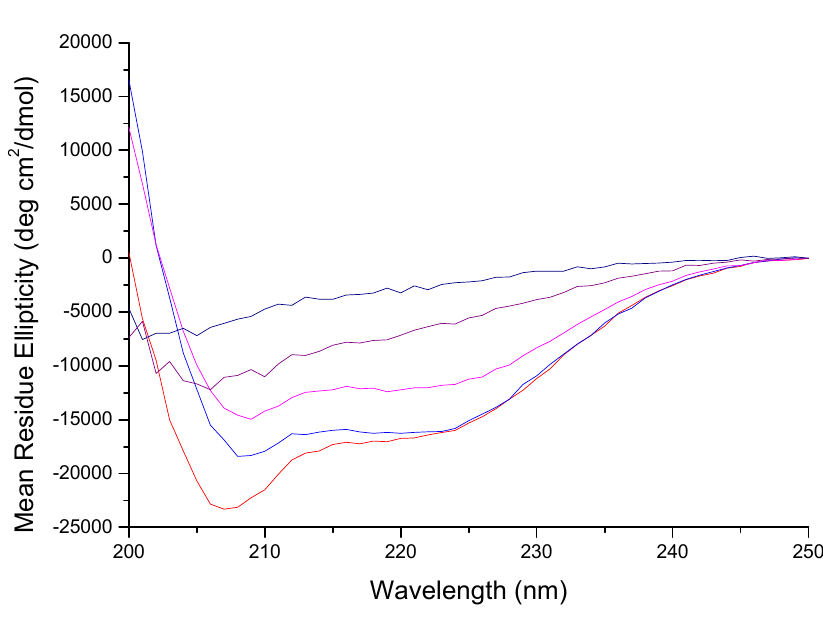
Figure 1. Circular dichroism of peptides in the presence of PE:PG:CL LUVs at a lipid/peptide ratio of 100:1. (red) CM15; (blue) D 1,13 ; (magenta) D 3,13 ; (purple) D 3,7,13 ; and (black) D 3,6,7,13,14